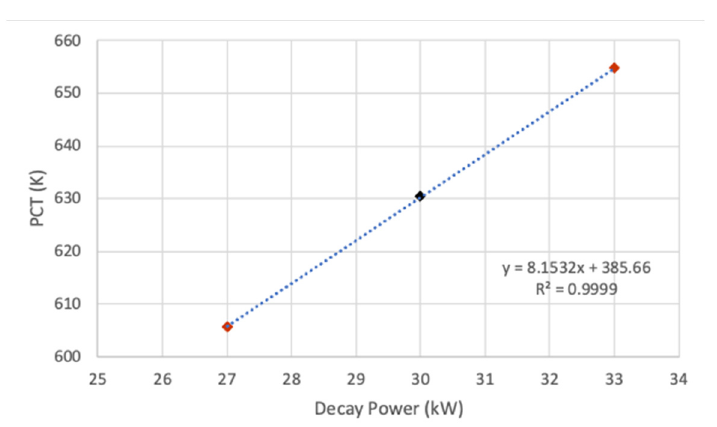
Figure 10. PCT vs. Figure 10. PCT vs. DCH.